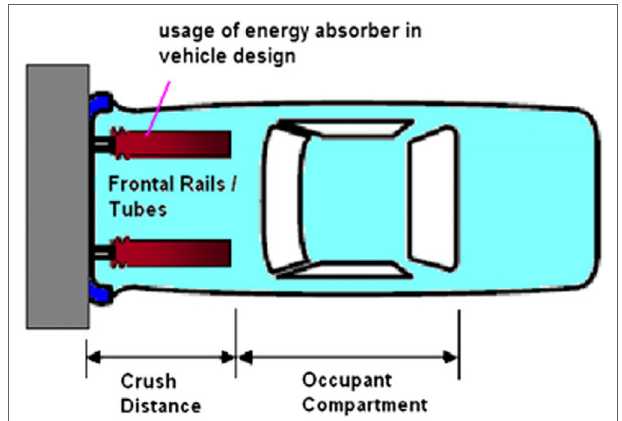
FigUre 14 | Application of crushable energy absorbers in automotive engineering [reproduced with permission (Farlochan et al.,